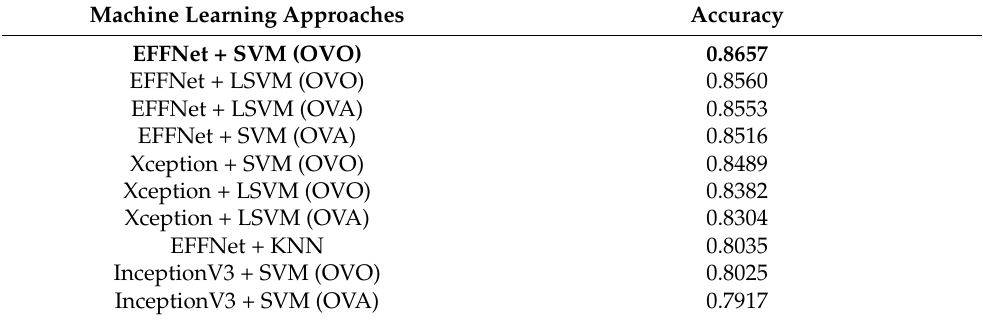
Table 17. The ten highest performing machine-learning approaches for VIREO-Food172 Dataset.